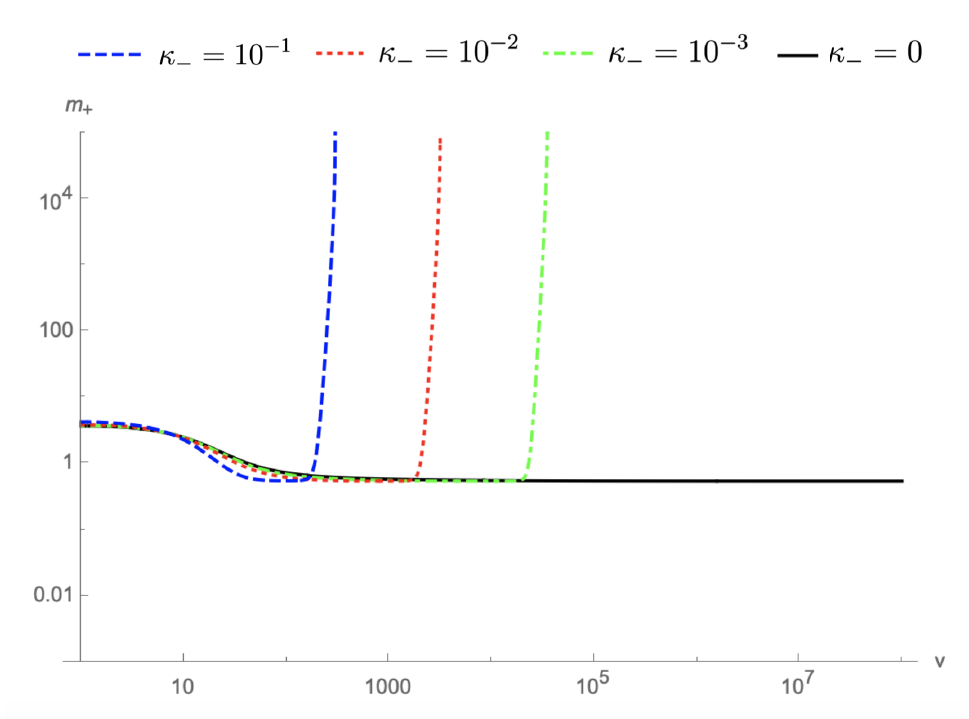
Figure 3 . Numerical evolution of the Misner-Sharp m + for different values of κ − . For the numerical integration we have considered M 0 = 100 , ‘ = 1 , α = β = v 0 = 1 , γ = 12 , a 2 = 10 M 0 ‘